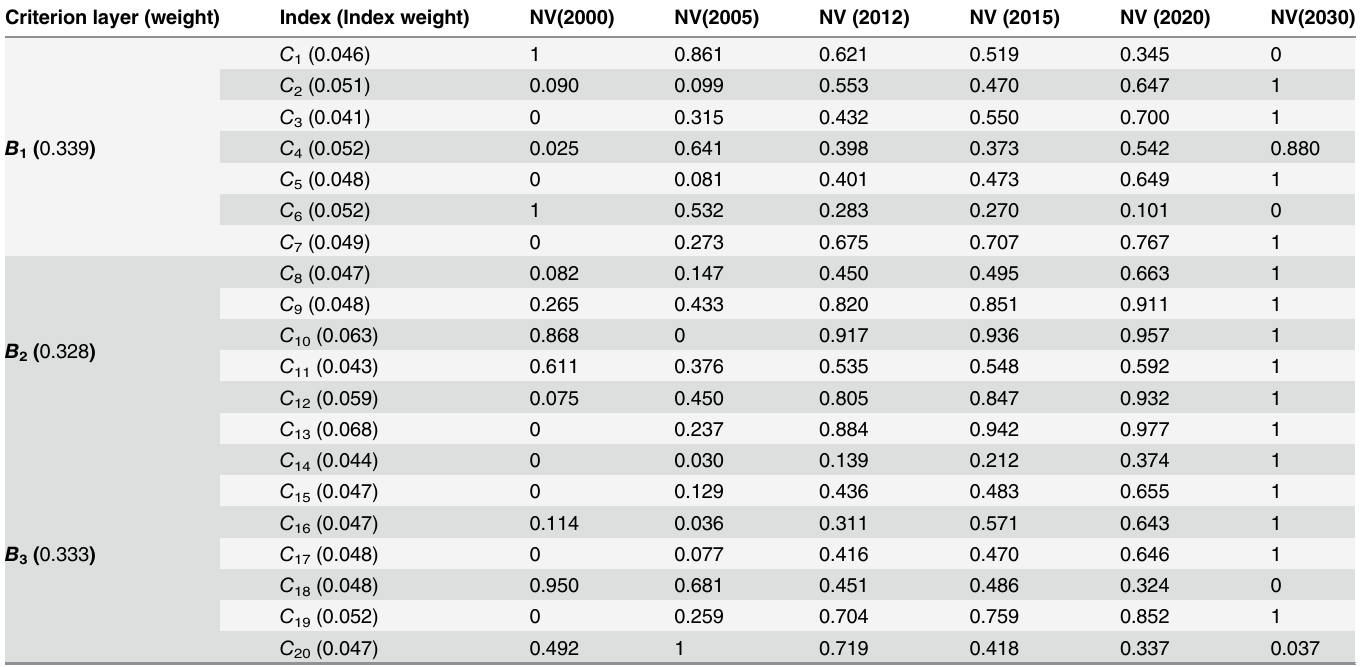
Table 5. Index weights and normalized values (NV) of ISM.